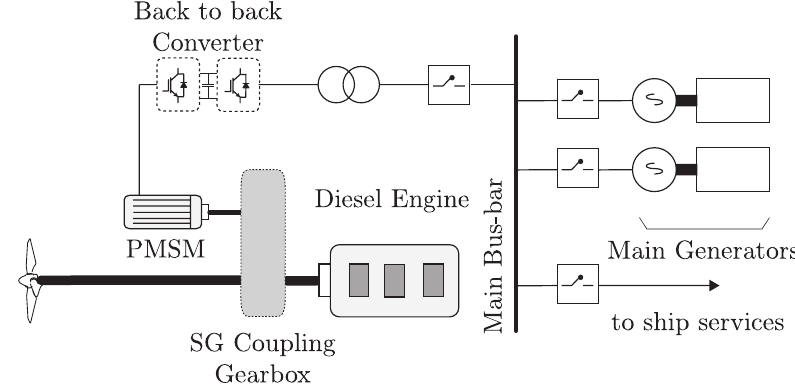
Figure 2. Hybrid propulsion system